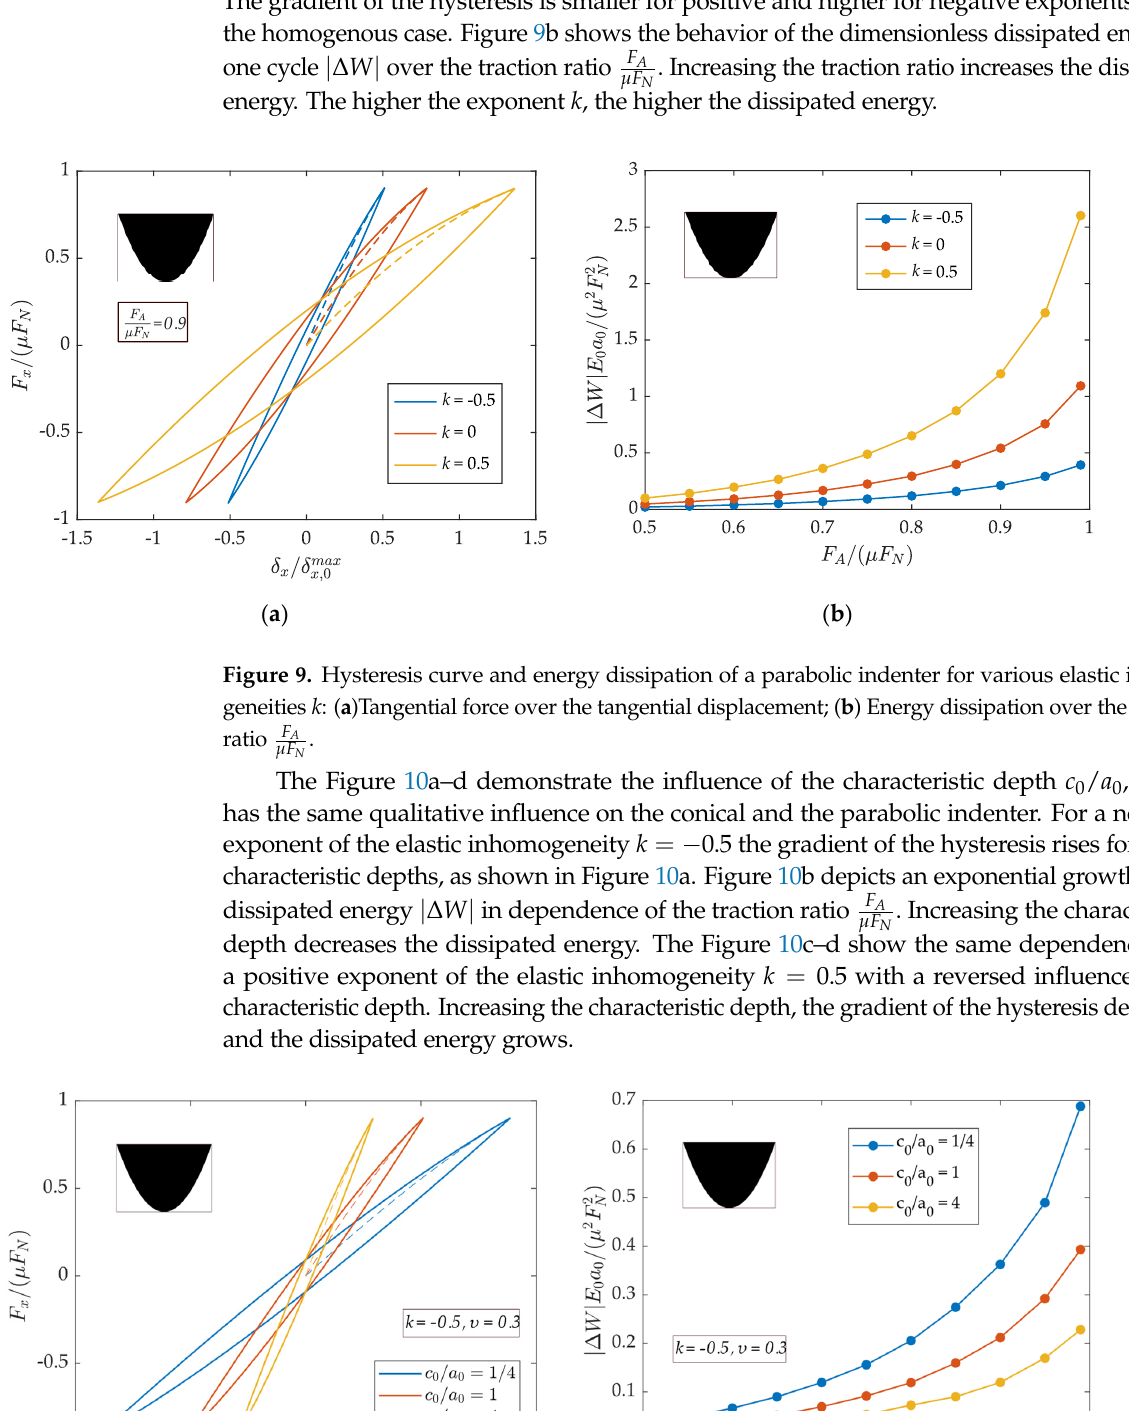
( d ) Figure 10. Hysteresis curve and energy dissipation of a parabolic indenter for a fixed elastic inho- mogeneity (cid:1863) and various quotients of the characteristic depth (cid:1855) (cid:2868) /(cid:1853) (cid:2868) : ( a ) Tangential force over tan- gential displacement for (cid:1863) = −0.5 ; ( b ) Energy dissipation over the traction ratio (cid:3007) (cid:3250) (cid:3091)(cid:3007) (cid:3263) for (cid:1863) = −0.5 ; ( c ) Tangential force over tangential displacement for (cid:1863) = 0.5 ; ( d ) Energy dissipation over the trac- tion ratio (cid:3007) (cid:3250) (cid:3091)(cid:3007) (cid:3263) for (cid:1863) = 0.5 . 4. Analytical Study on Frictional Energy Dissipation Since the relationships between the externally applied forces, the relative rigid body displacements, and the stick and contact radius of the original problem, exactly emerge from the (fictional) equivalent contact problem in the Abel domain, it is possible to deter- mine the energy dissipated per cycle from it, as well. One way is to evaluate the work carried out by the tangential force on the tangential rigid body displacement of the plane rigid indenter during a complete cycle. Another, perhaps less elaborate way, is to consider the energy dissipation over a complete cycle for each single spring contact and subse- quently sum up the energy loss of all spring contacts. Figure 11 illustrates the variation of